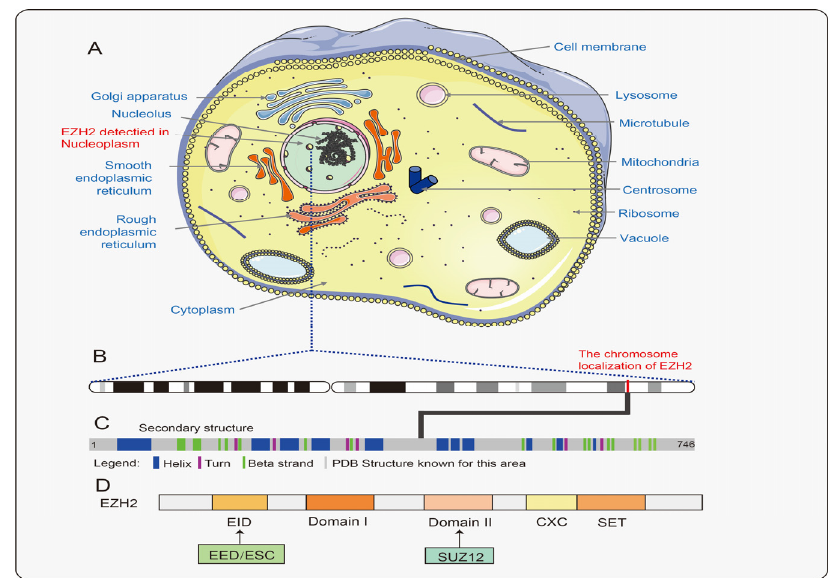
Figure 2. The gene and protein structure of the EZH2. ( A ) The location of the EZH2 protein in the cell. ( B ) The chromosome localization of EZH2. ( C ) The protein secondary structure of EZH2. ( D ) Schematic representation of the organization of the five functional domains in EZH2 is depicted. The EID structural domain is the binding site for the EED subunit in the RC2 complex. The domain II structural domain is the linkage site for the SUZ12 subunit in the PRC2 complex. The SET structural domain is the site that exerts methyl transfer activity and is also the binding site for SAM. The CXC structural domain also contributes to methyl transfer activity, whereas the function of the domain I structural domain is not